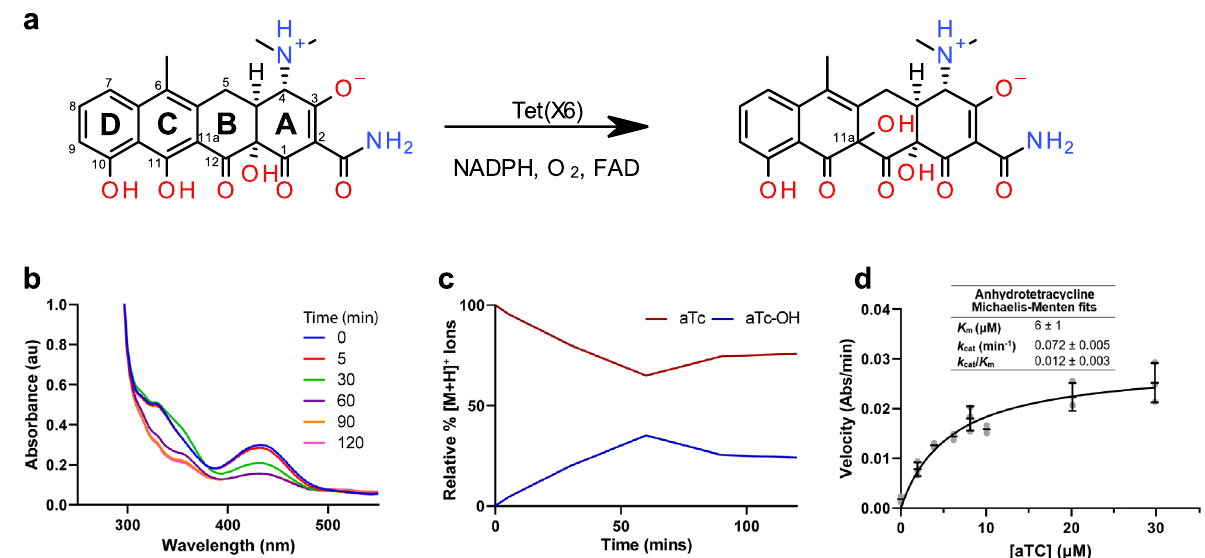
Fig. 5 Anhydrotetracycline oxidation is catalyzed by type 1 TDases. a C11a is the plausible site of oxidation in aTC. b Degradation of aTC as observed via optical absorbance spectroscopy. c Extracted mass ion counts (normalized as relative %) for aTC and oxidized aTC-OH from LC-MS of Tet(X6) reaction from panel ( b ). d Michaelis-Menten steady-state kinetic curve for Tet(X6)-catalyzed degradation of aTC. Error values represent standard deviations for three independent